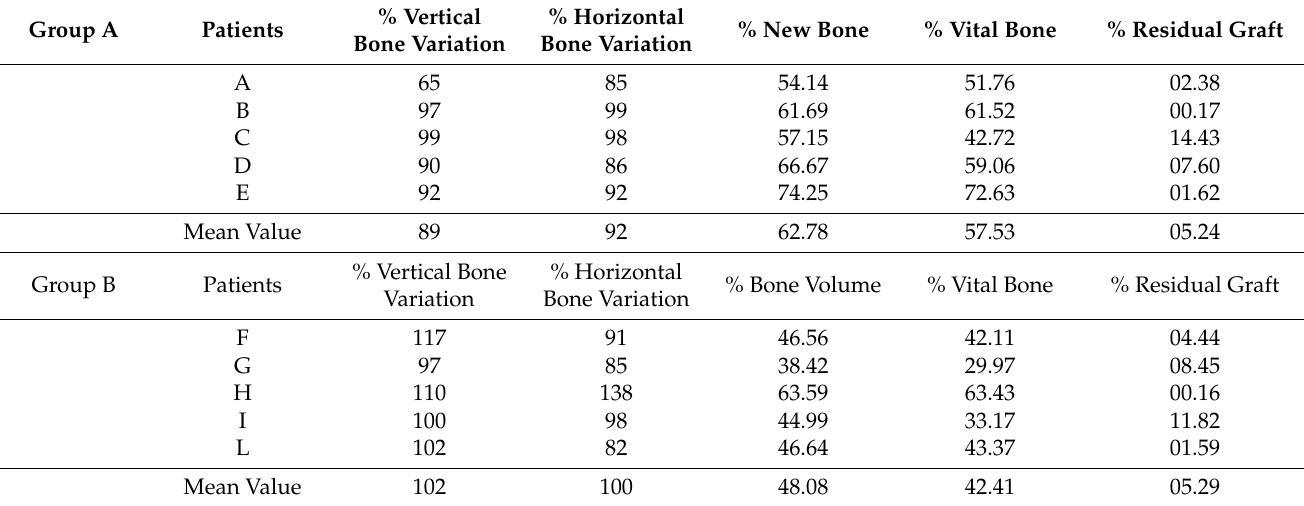
Table 1. Histological and histomorphometrical variations of bone biopsies in Group A (GA) and Group B